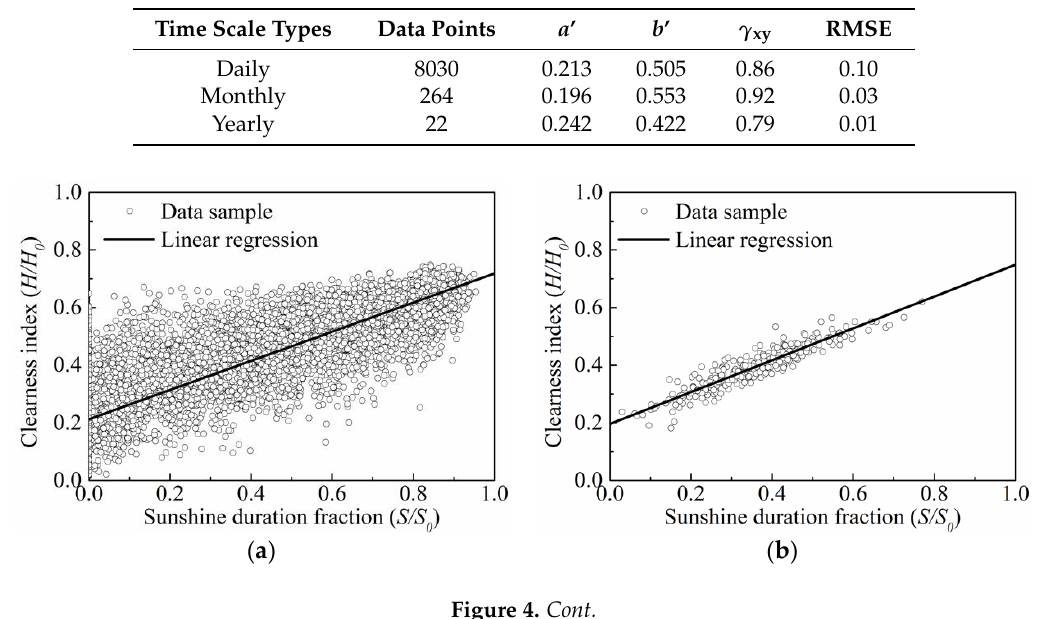
Table 1. Linear regression analysis of clearness index and sunshine duration fraction using different time scales.